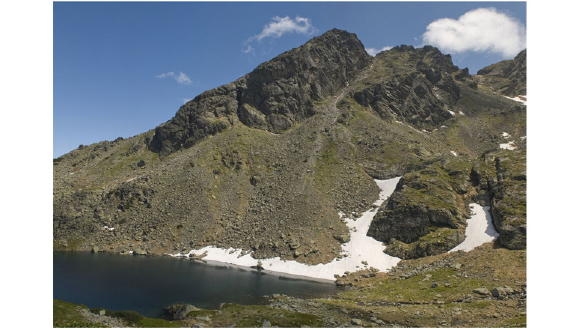
Figure 1. Study area – the western slopes of the Ko ś cielec Mt.